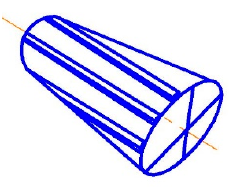
Figure 2. Screw cutting system of the chopper.